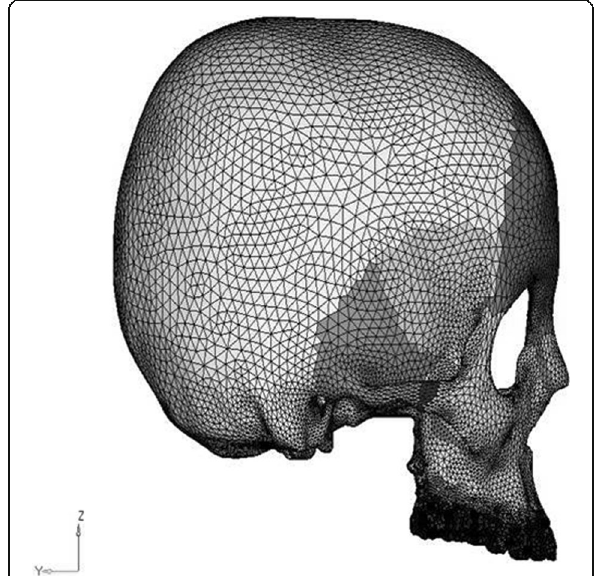
Fig. 3 Lateral view of the three-dimensional FE model